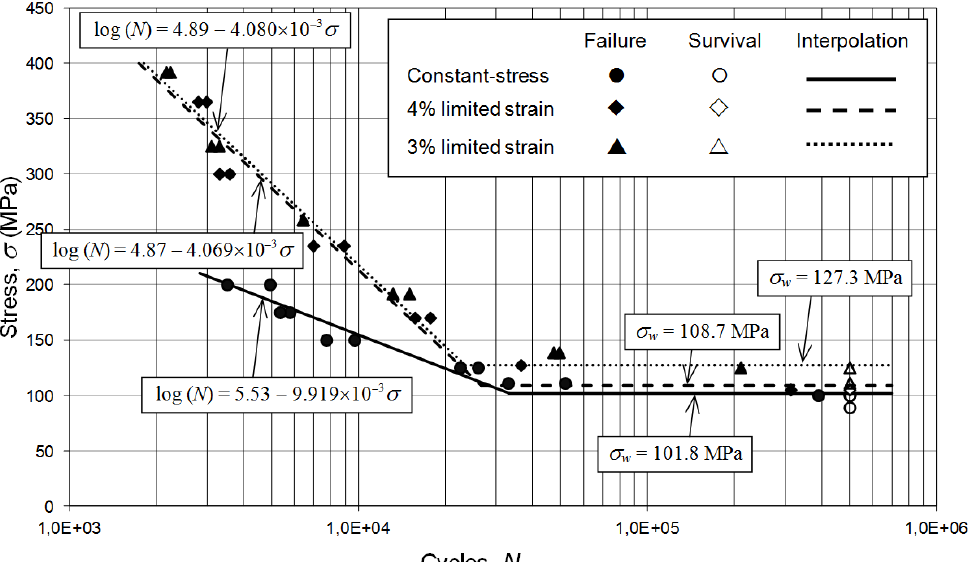
Figure 3: Woehler’s diagram with the fatigue results for the constant-stress tests and the tests at constant stress with limited maximum strain (3% and